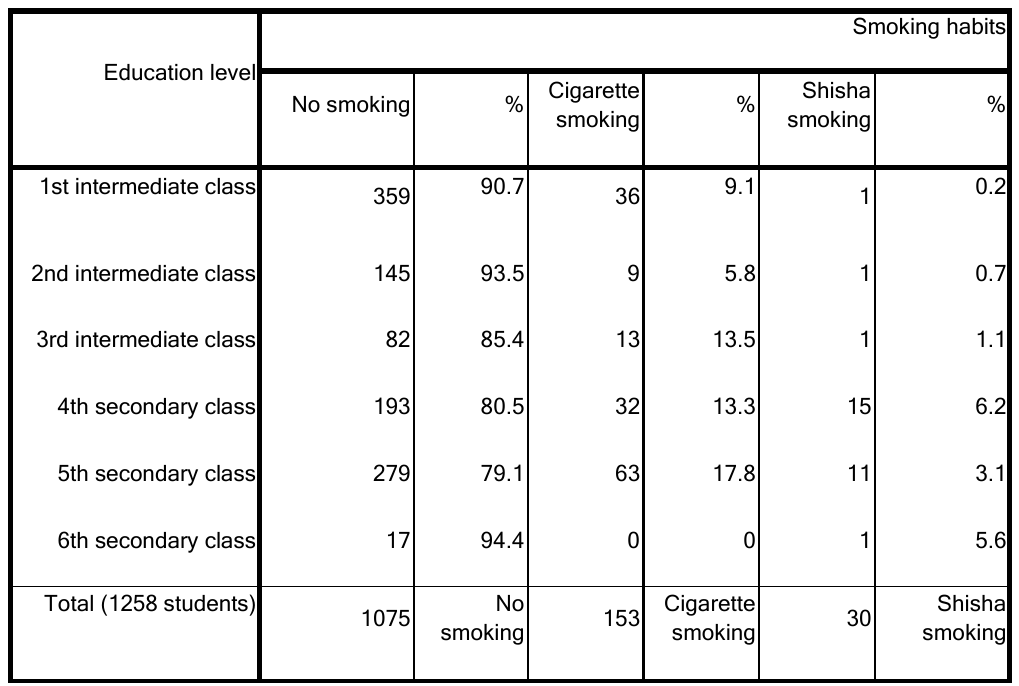
Table 2 the prevalence of smoking among students according to their level of education and smoking